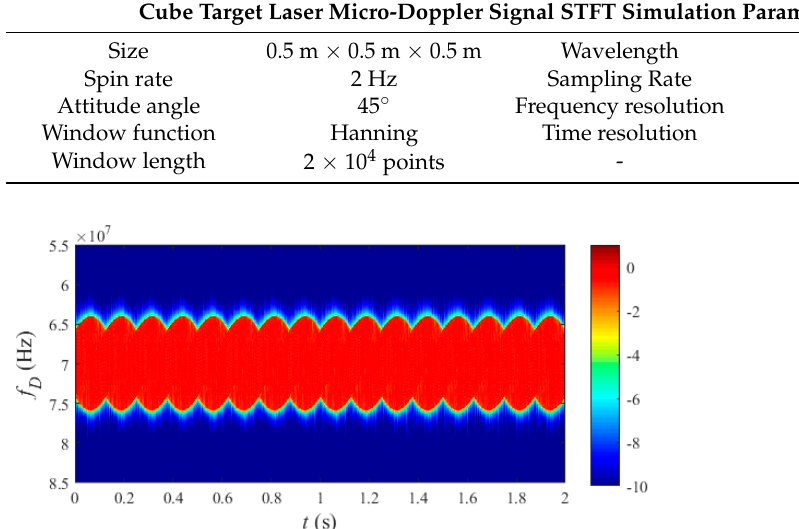
Figure 3. Time − frequency diagram of laser micro − Doppler echo signal of cube target.